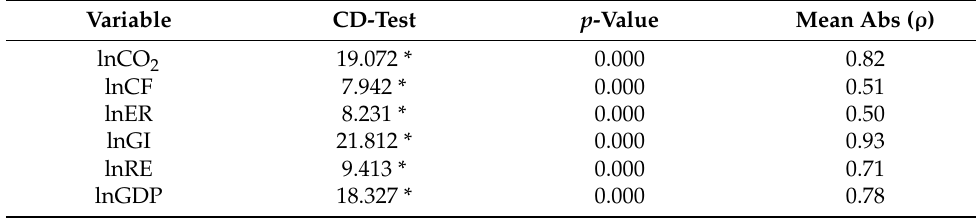
Table 4. Cross-sectional dependency test results.